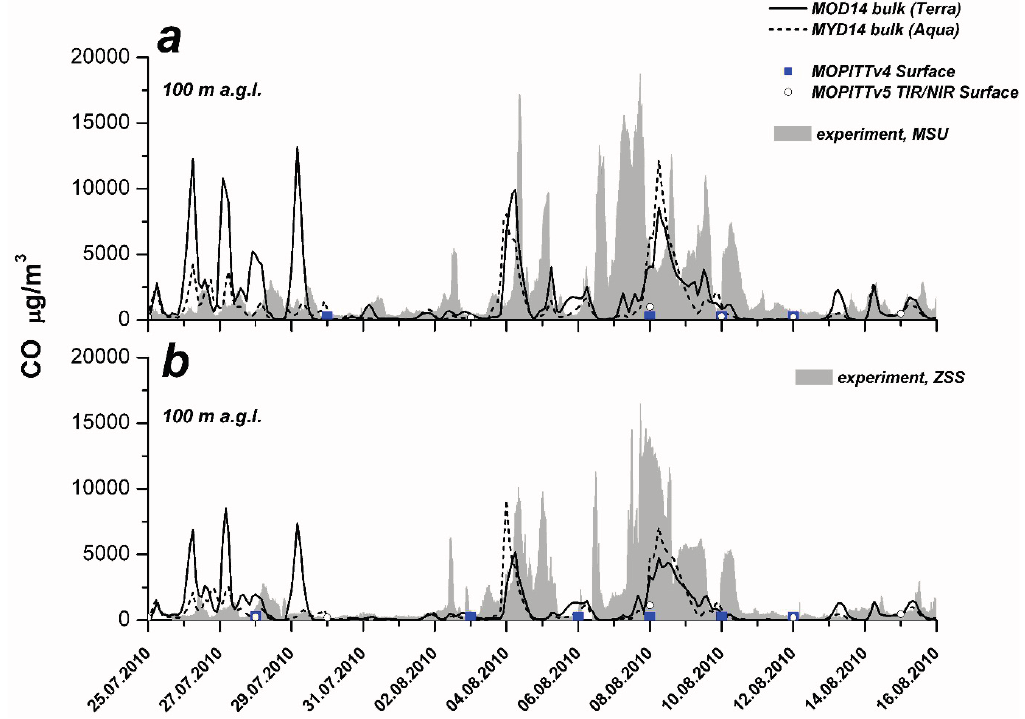
Figure 8. Experimental data for MSU ( a ) and ZSS ( b ) stations and model RAMS/HYPACT CO concentrations, at heights of 100 m a.g.l. The concentrations have been predicted by the model with using of the MOD14 (Terra, solid line) and MYD (Aqua, dashed line) bulk methods. The grey areas correspond to the experimental data. In addition surface CO concentrations of MOPITTv4, MOPITTv5 TIR/NIR satellite data are